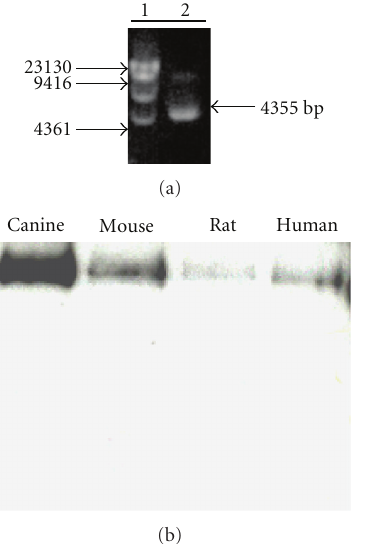
Figure 3: (a) Restriction digestion analysis of the canine HRI- bacmid DNA verifies the insertion of canine HRI cDNA into the bacmid DNA with correct orientation. Lane 1, Molecular Weight markers; Lane 2, pFastBac-canine HRI cDNA. (b) Expression of mammalian HRIs. HRI, expressed in insect cells, was detected by Western blot analysis using an a ffi nity purified mouse monoclonal antibody against histidine and visualized by enhanced chemilumi- nescence. Lane 1, canine HRI; Lane 2, mouse HRI; Lane 3, rat HRI; Lane 4, human HRI.